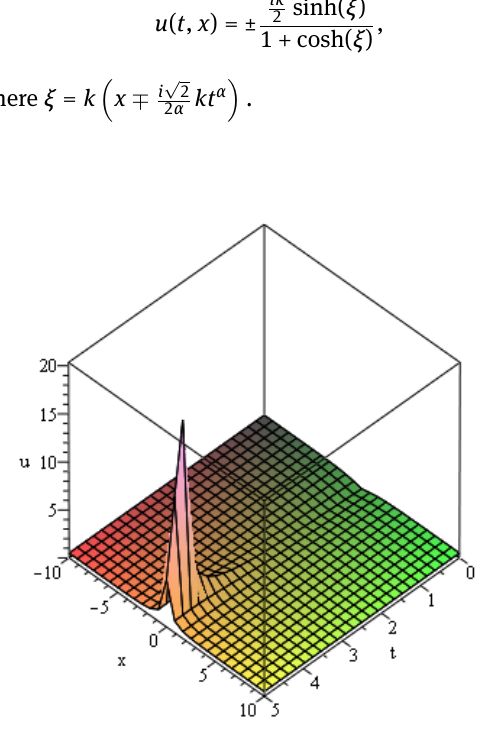
Fig. 4: The obtained soliton solution of Eq. (4) ( | u | ): α = 0.9; k = 1; −10 ≤ x ≤ 10;0 ≤ t ≤